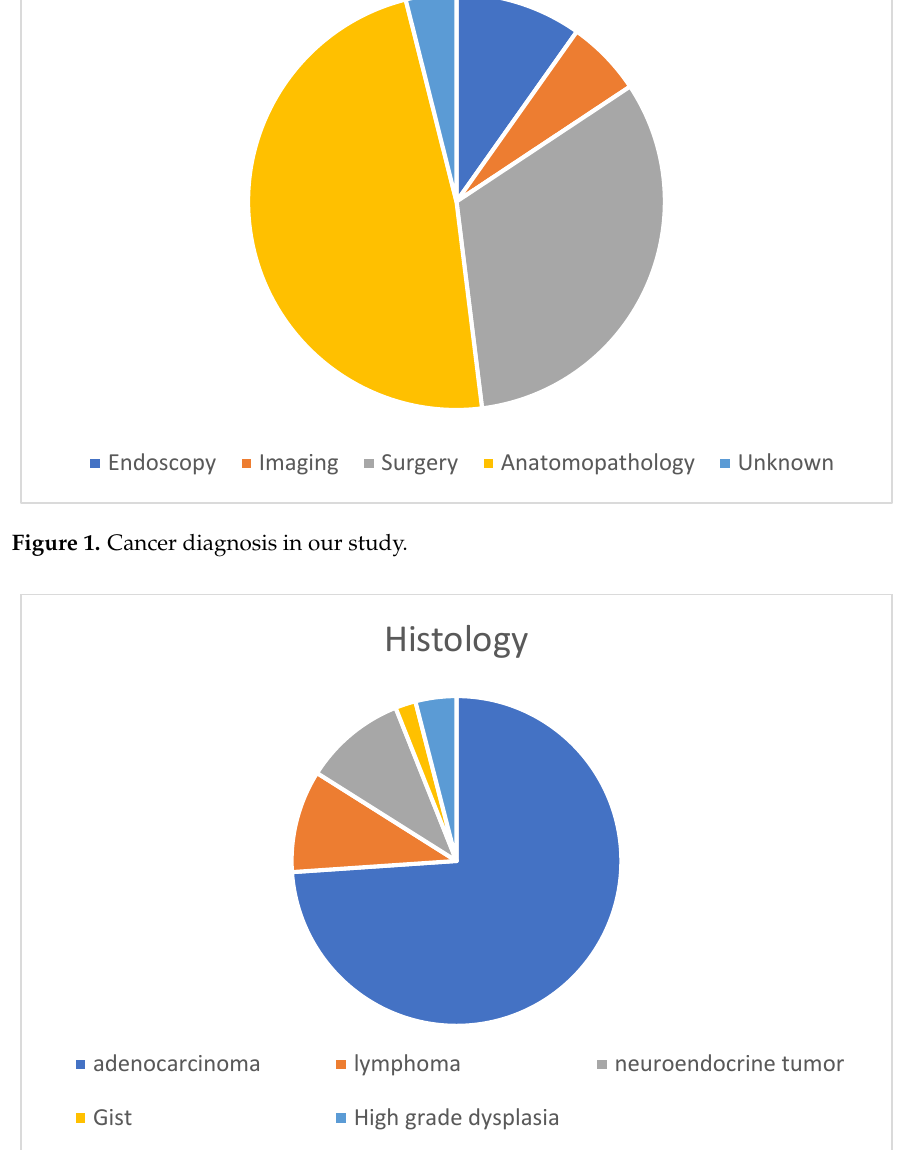
Table 5. Predictors of small bowel neoplasia in multivariable and Cox regression analyses, n = 200.